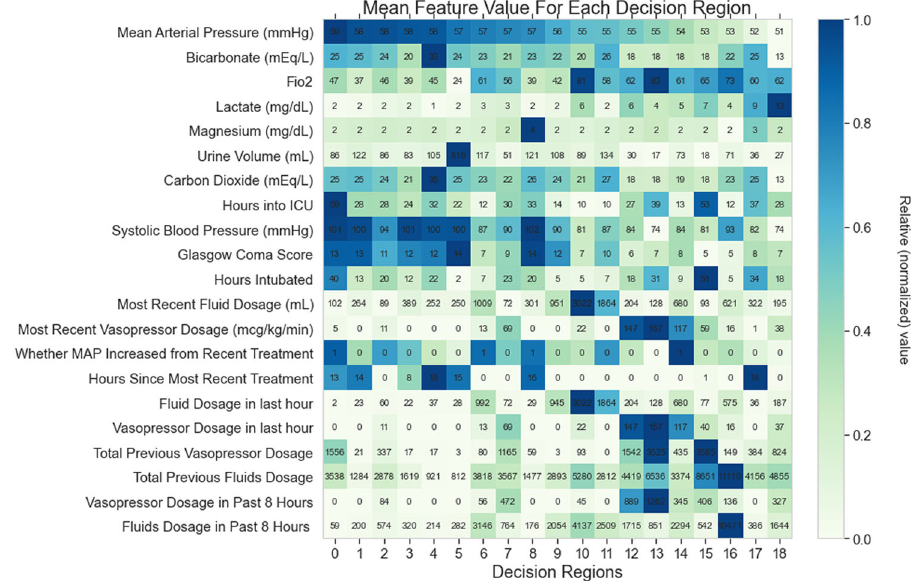
Fig. 3 The feature means for points in each decision region. Means are sorted by descending order of Mean Arterial Pressure (MAP)